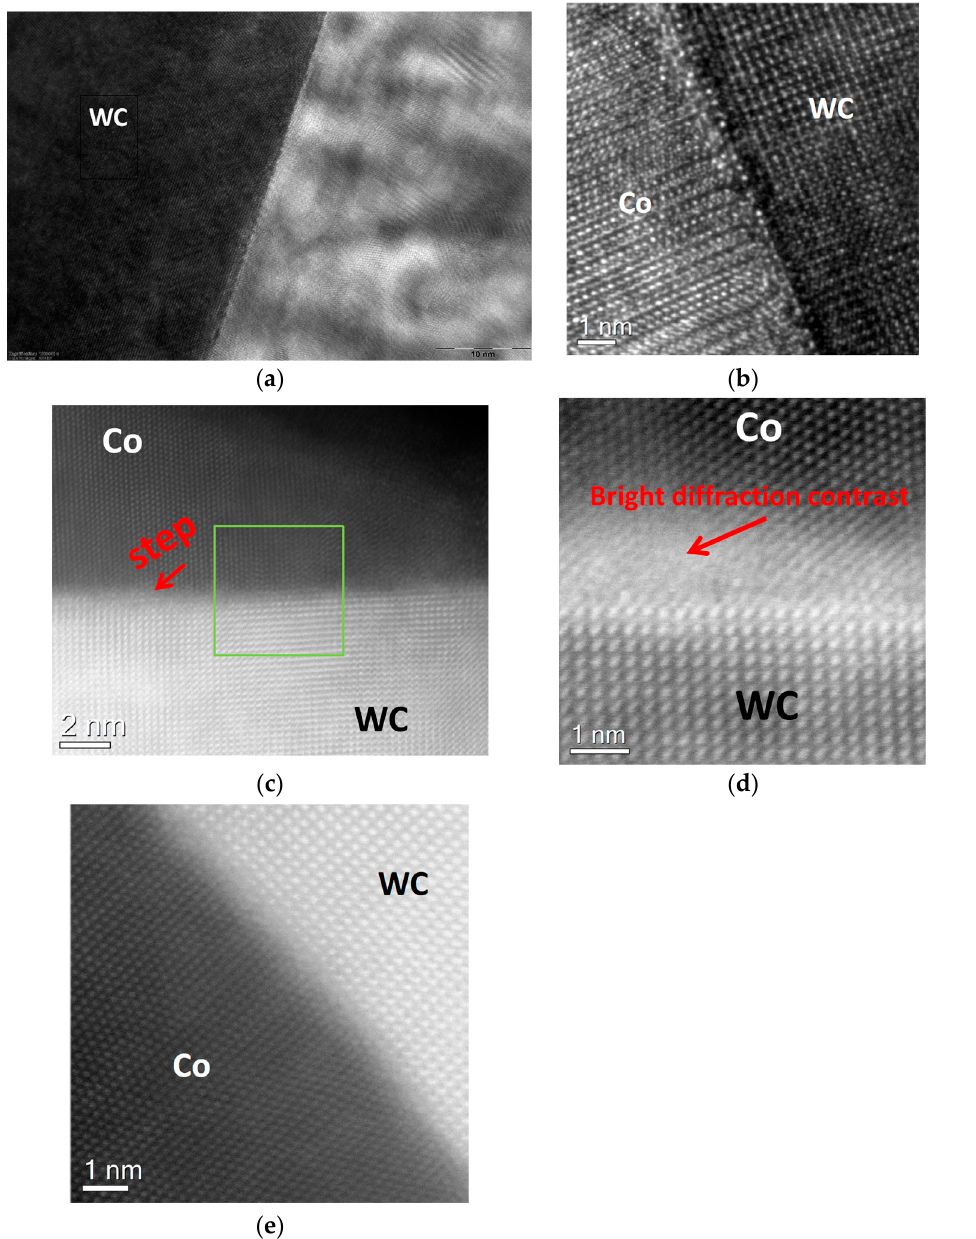
Figure 6. WC-Co interfaces in the sample obtained after melting the alloy with the high carbon content on the WC surface: ( a ) Binder nano-structure near the interface (JEOL JEM-2100); ( b ) HRTEM image of the interface (JEOL JEM-2100); ( c ) HAADF STEM (Z-contrast) image of the interface; ( d ) ADF STEM (both diffraction- and Z-contrasts) image of the interface; ( e ) Fourier-filtered high-resolution STEM image of the interface (FEI Titan 80–300).